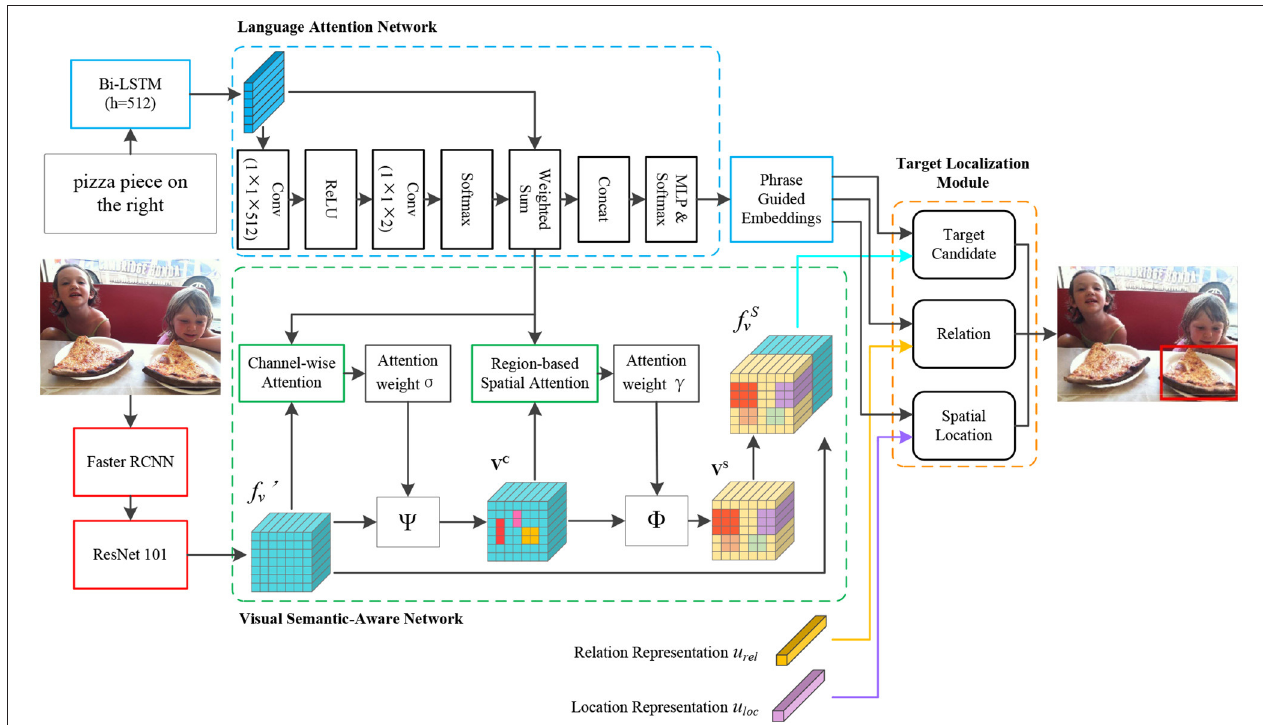
FIGURE 2 | Semantic-Aware network for referring expression comprehension. We adopt the language attention network to compute the different weights for each word in expressions, and learn to parse the expressions into phrases that embed the information of target candidate, relation, and spatial location, respectively. We conduct both channel-wise and region-based spatial attention to generate semantic-aware region visual representation. We further combine the outputs of the visual semantic-aware network, the language attention network, and the relation and location representations to locate the target objects. In the figure, f ′ v denotes the projected deep features, V C represents the channel-wise weighted deep feature, V S is the spatial weighted feature, f S v is the generated semantic-aware visual representation by concatenating f ′ v and V S , the details are described in section 4.2. The relation representation u rel , the location representation u loc , and the details of the target candidate module, the relation module, and the location module are introduced in section 4.3. 9 denotes a channel-wise multiplication for f ′ v and the generated channel-wise attention weight σ , 8 represents element-wise multiplication for V C and the acquired spatial attention weight γ (Best viewed in